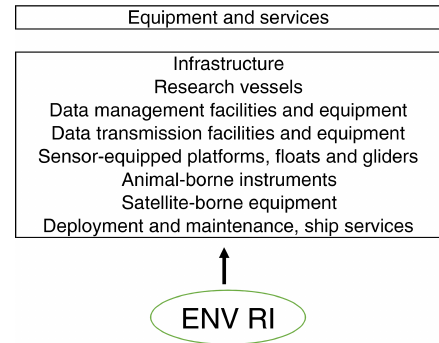
Figure 1. Upstream impacts: list of the main categories of equip- ment and services supplied to ENV RIs.